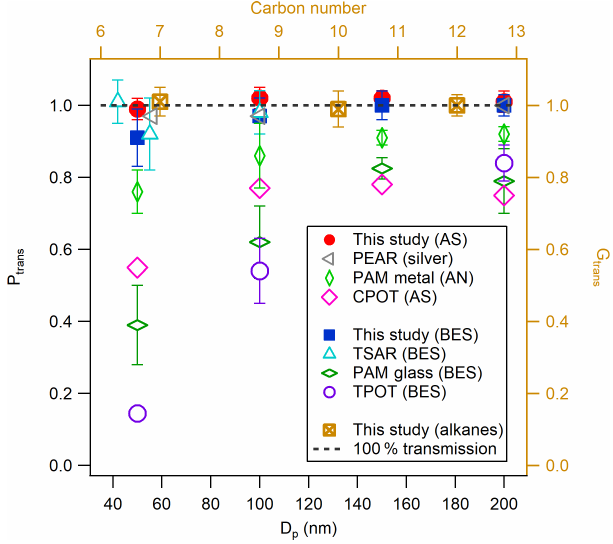
Figure 2. Particle (left and bottom axis) and gas (right and top axis) transmission efficiencies ( P trans and G trans ) for the ECCC-OFR. Particle transmission efficiencies of other OFRs are shown for com- parison: PAM glass and TPOT (Lambe et al., 2011), PAM metal (Karjalainen et al., 2016), TSAR (Simonen et al., 2017), CPOT (Huang et al., 2017), and PEAR (Ihalainen et al.,